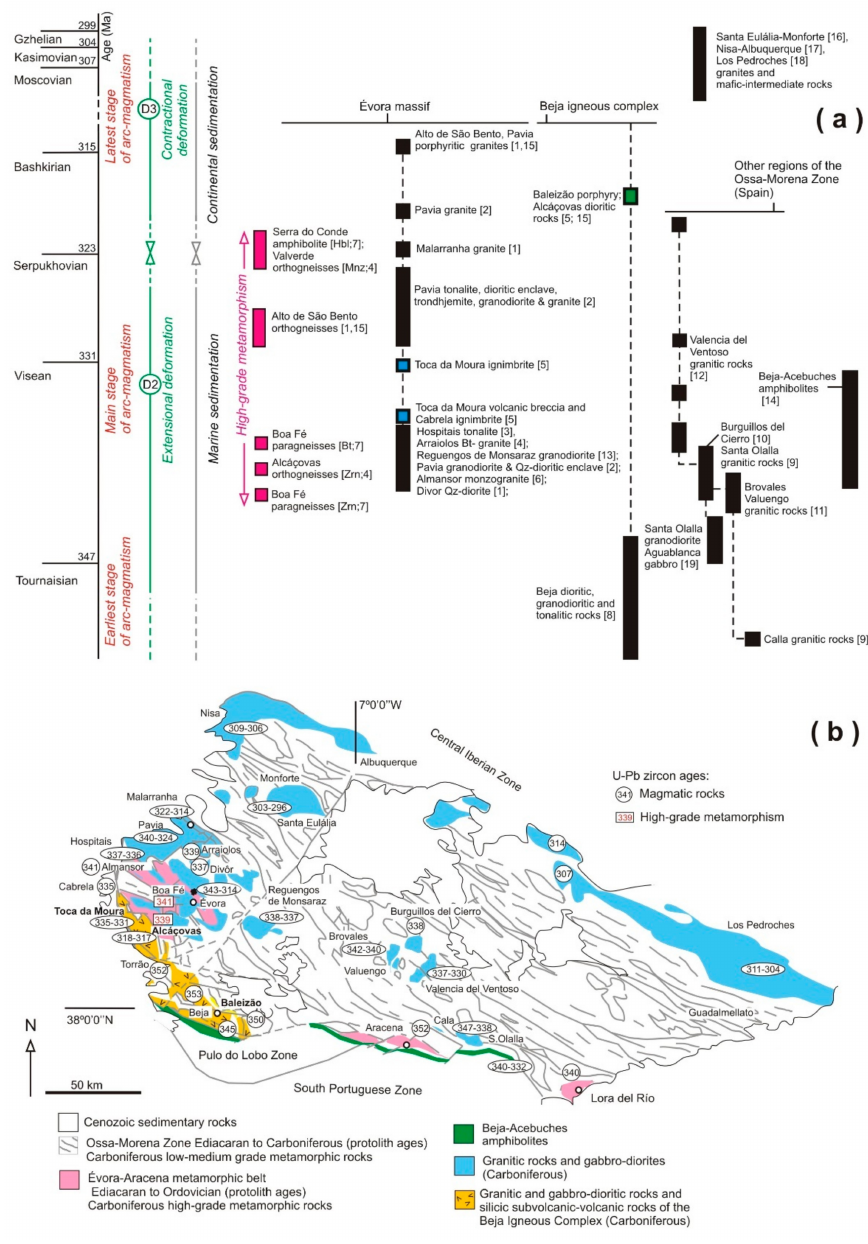
Figure 8. ( a ) Timeline of the stages of Carboniferous arc magmatism, and high-grade metamorphism, deformation, and sedimentation events, represented in the Ossa-Morena Zone (mostly focused on the É vora gneiss dome and the Beja Igneous Complex; geochronology data from: 1 [34];2 [26]; 3 [25]; 4 [33]; 5 [16]; 6 [44]; 7 [43]; 8 [23]; 9 [19]; 10 [67];11 [68]; 12 [29]; 13 [69]; 14 [70]; 15 [18]; 16 [71]; 17 [72]; 18 [73] and 19 [74]; compiled magmatic (black bars) and metamorphic (magenta bars) ages; U-Pg ages from this study (dark blue and green bars); ( b ) simplified geological map of the Ossa-Morena Zone showing a compilation of magmatism and metamorphism ages (adapted from